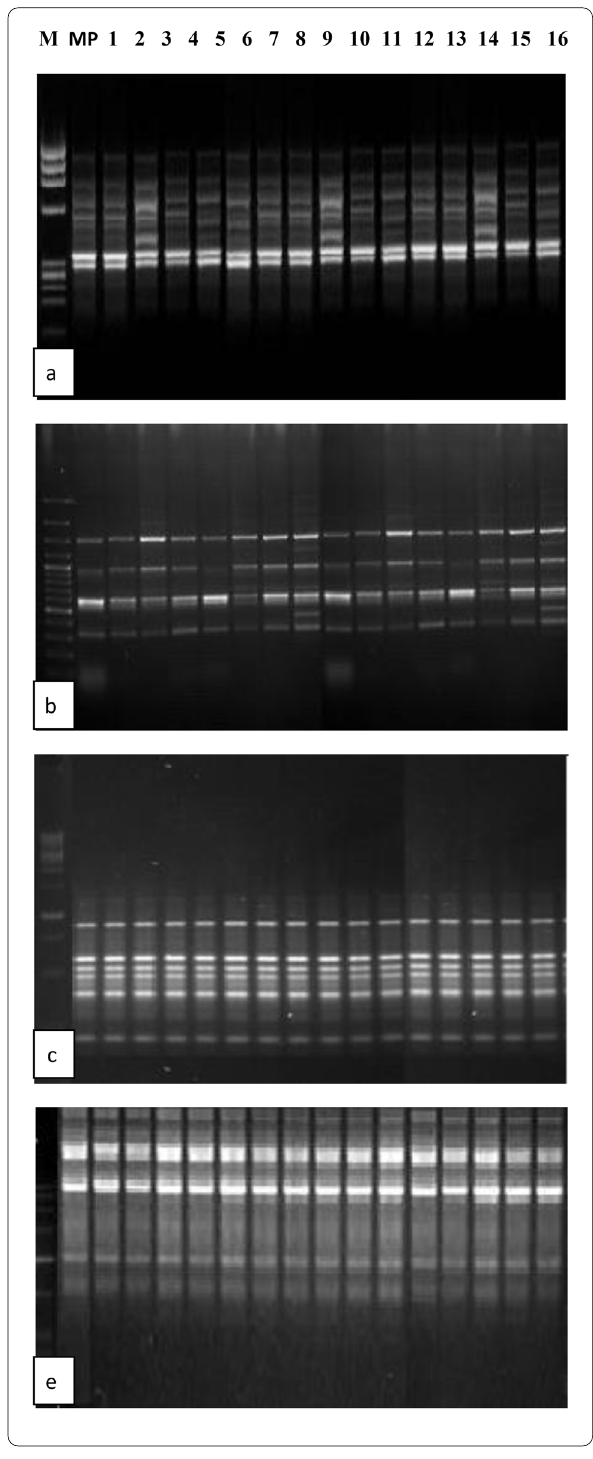
Fig. 5 a OPB‑05, b OPE‑08, c OPE‑15, and d OpO‑07). RAPD pattern of regenerated plants of Phoenix dactylifera L. on MS medium supplemented with chitosan (CHT) alone or in combination with thidiazuron (TDZ): mgL − 1 :(M) size marker (1) (1) MP: mother plant,